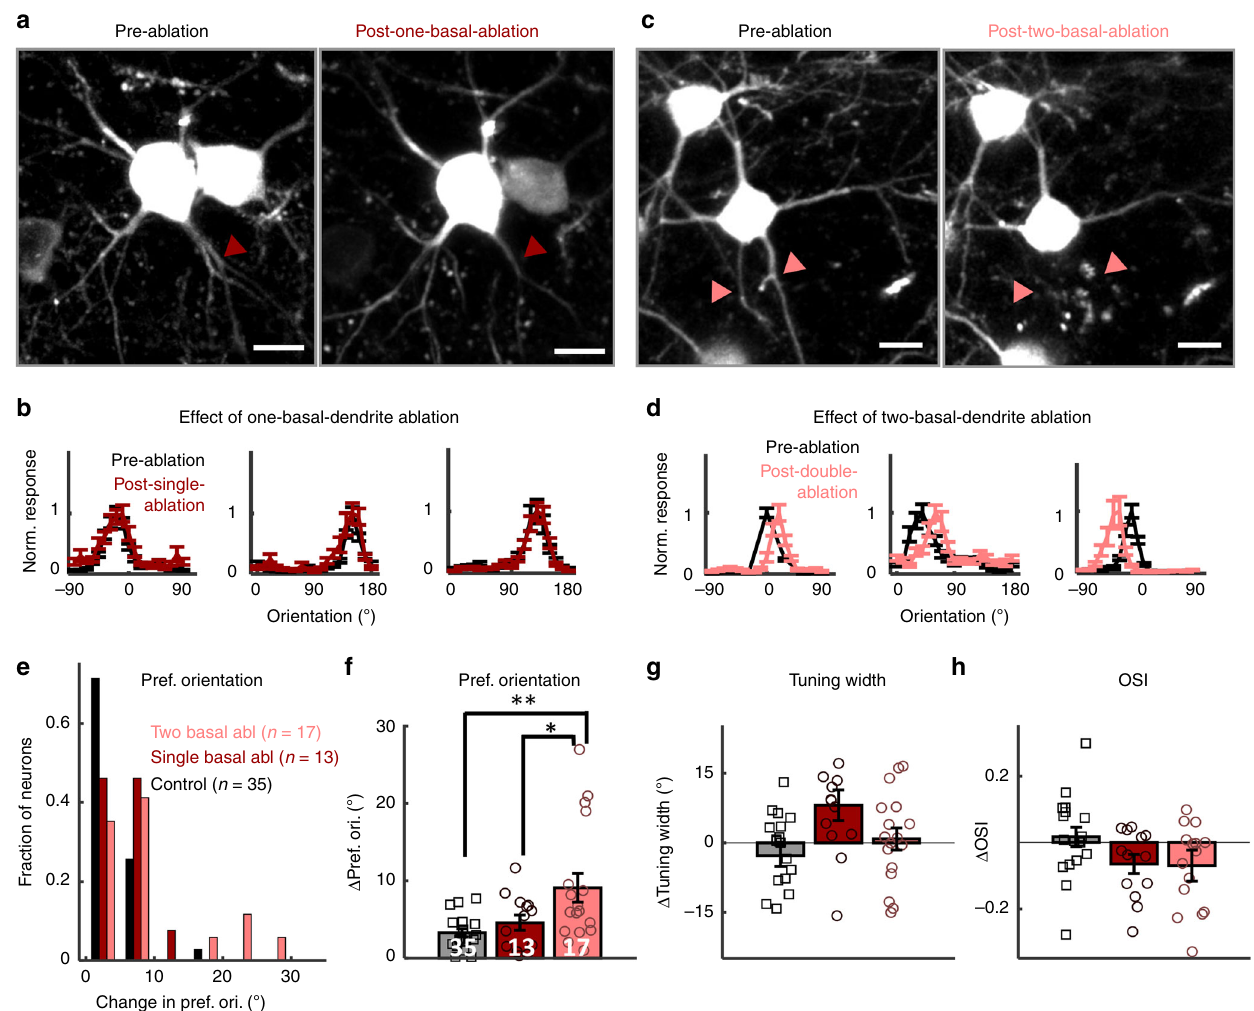
Fig. 3 Removal of two, but not one, primary basal dendrites shifts orientation preference. a Z-stacked top view of an example ablated neuron and a neighboring control neuron before (left) and after (right) a single primary basal dendrite ablation. Ablated dendrite is marked with dark-red arrow. b Three examples of peak-normalized orientation-tuning curves before (black) and 5 days after one-basal-dendrite ablation (dark-red). c , d Figures in the same format with a-b for two-basal-dendrite ablation (marked with pink). Error bars are standard error of mean across trials. e Histogram of the absolute-value change in preferred orientation (deg) for control (black, n = 35), one-basal-ablation (dark-red, n = 13), and two-basal-ablation (pink, n = 17) neurons.